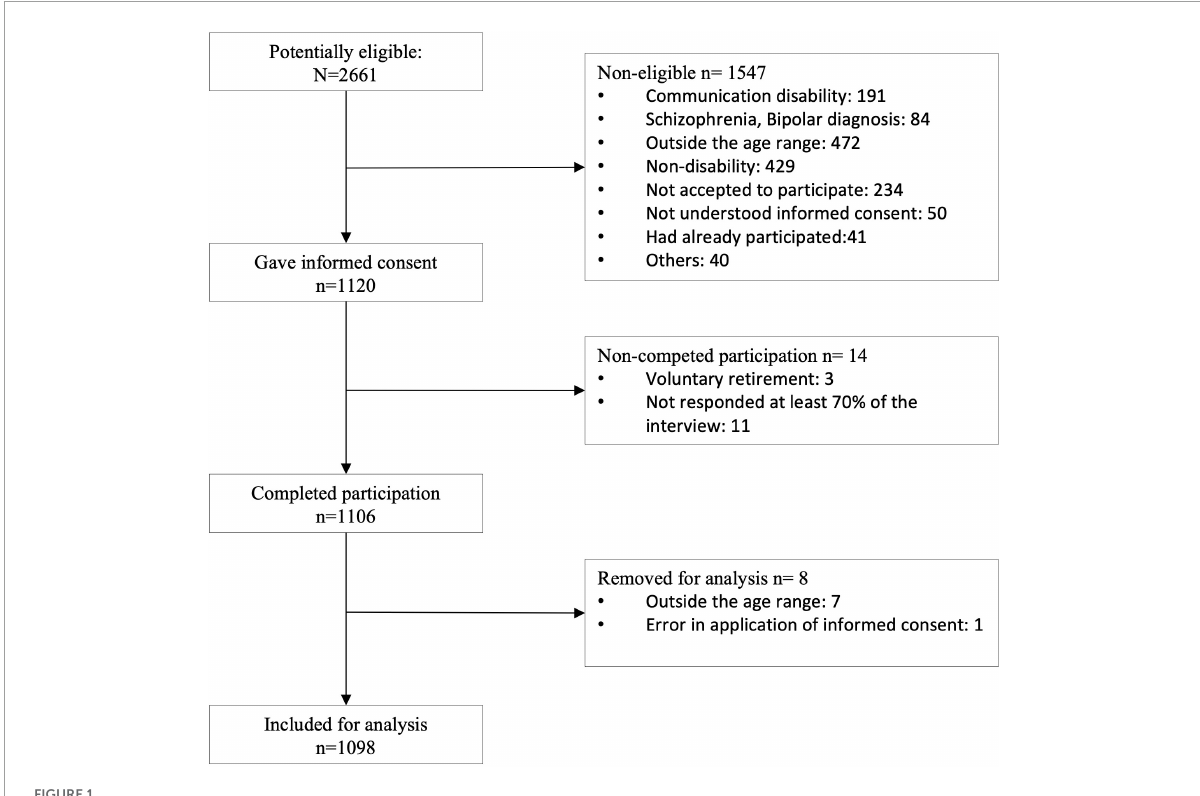
FIGURE1 Participants flow